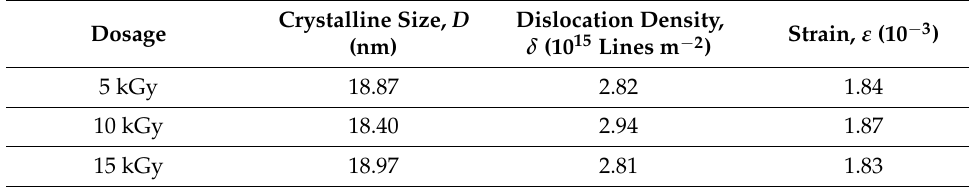
Table 1. Values of structural variables of irradiated IZO thin films.